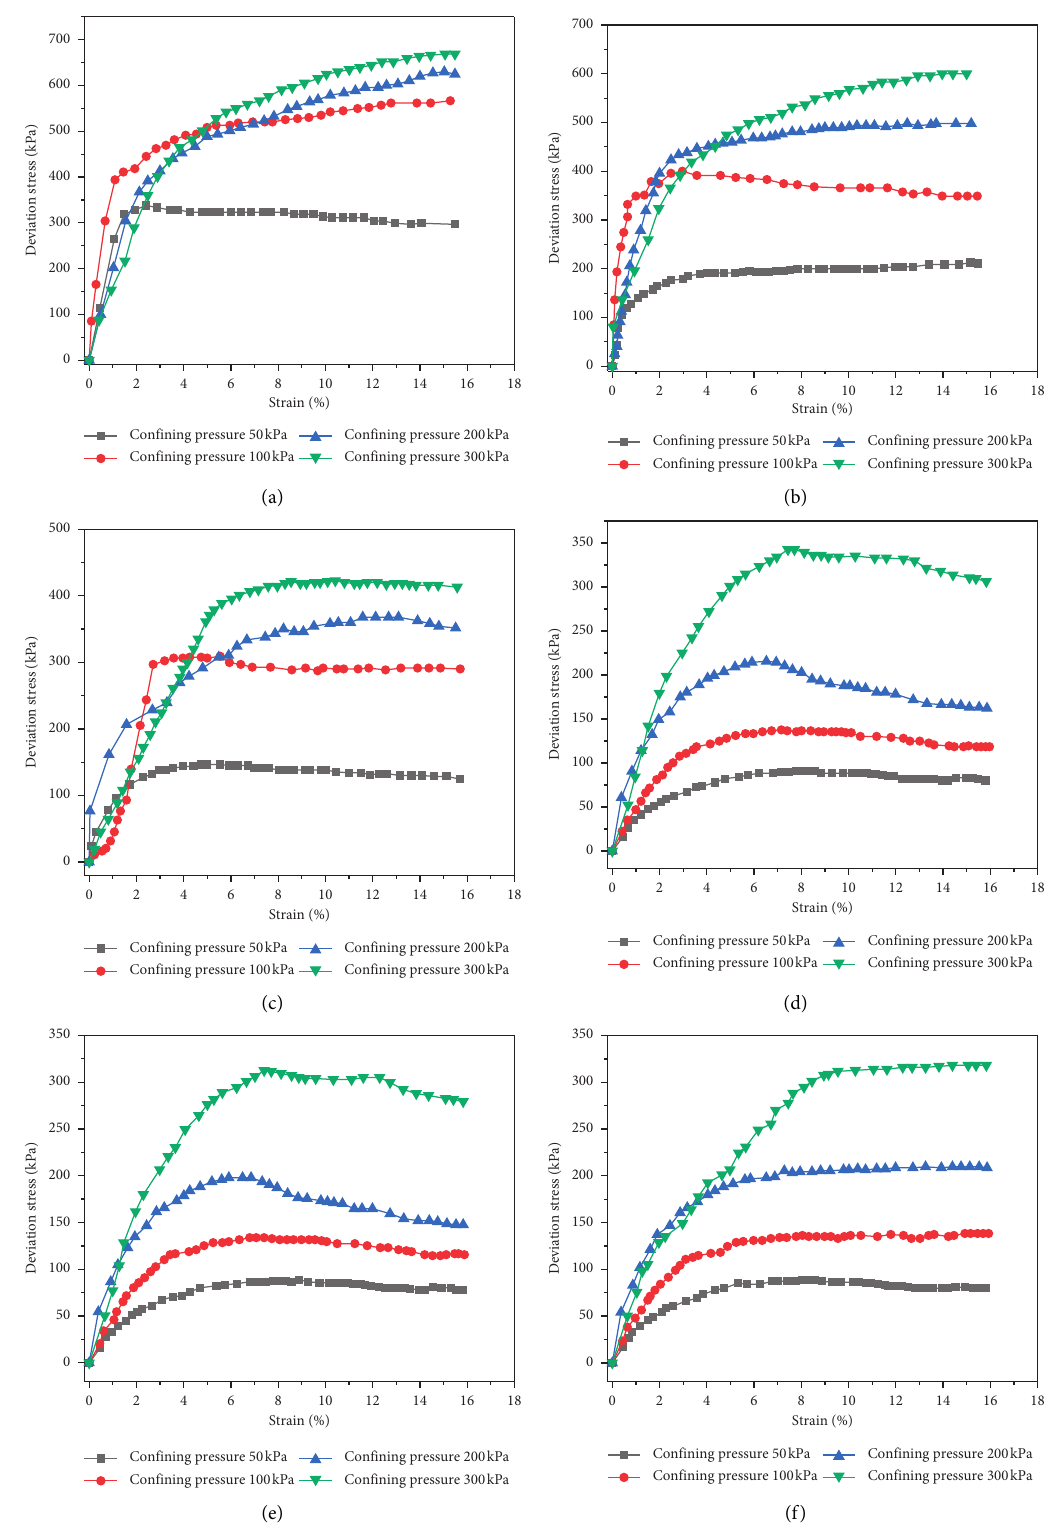
Figure 9: Stress-strain curves of the samples with an initial water content of w � 10% for different numbers of cycles. Moisture content w � 10% for (a) zero cycles, (b) one cycle, (c) two cycles, (d) three cycles, (e) four cycles, and (f) five